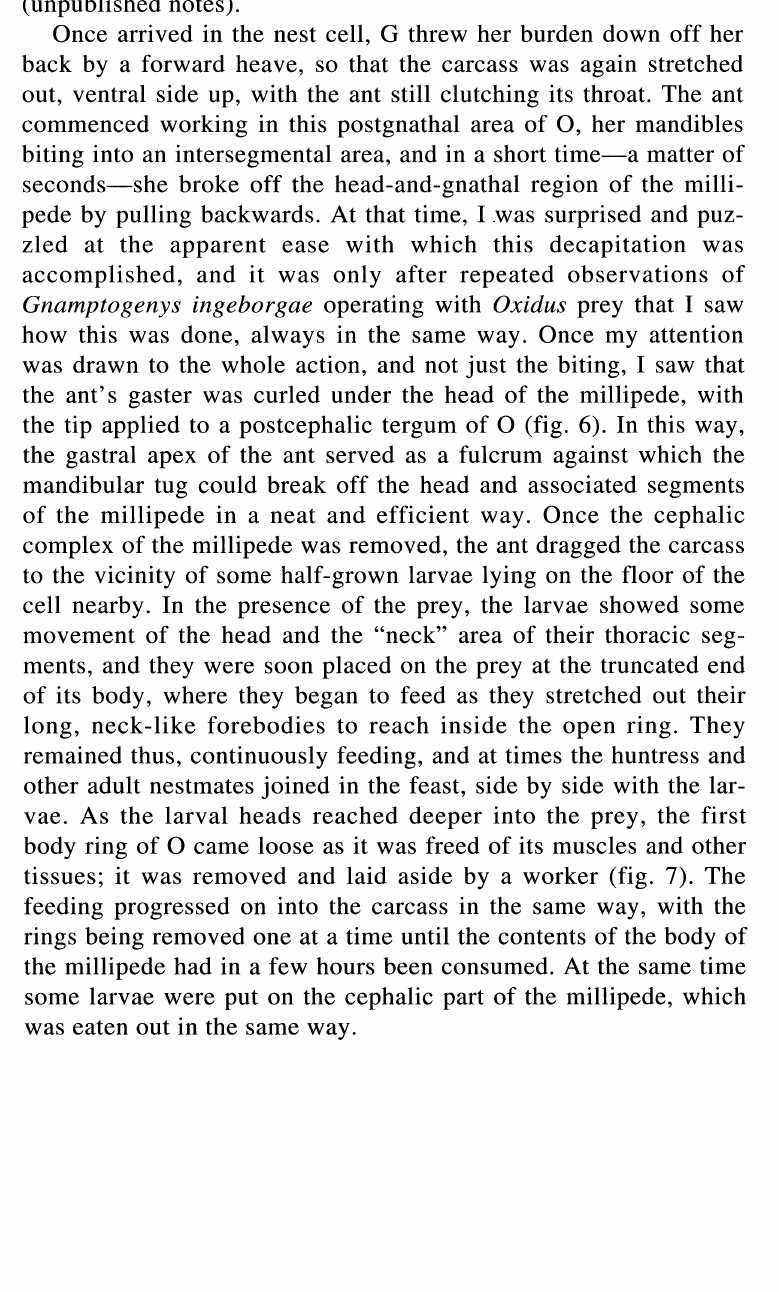
figure in W. M. Mann’s National Geographic Magazine